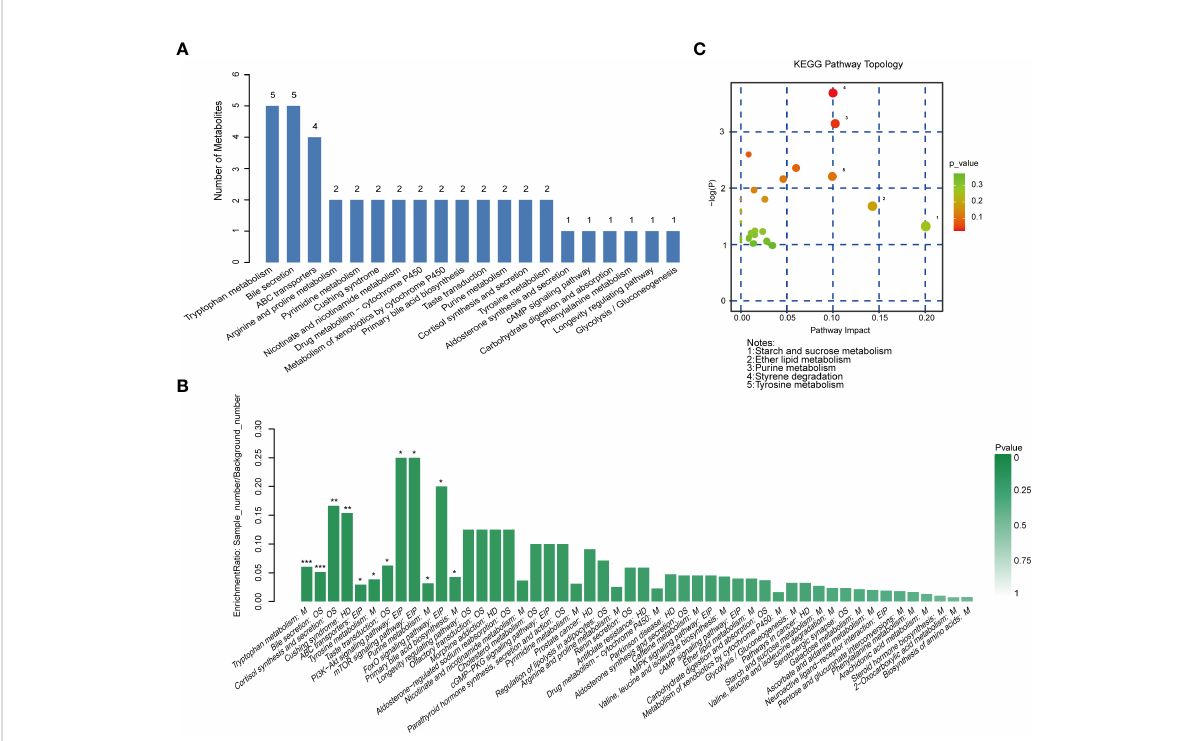
FIGURE 7 Metabolic pathway analysis. (A) Histogram of the top 20 pathways containing the most different metabolites. (B) Histogram of KEGG pathway enrichment analysis of differential metabolites. *** p < 0.001, ** p < 0.01, * p < 0.05. (C) Bubble chart of KEGG topology analysis.